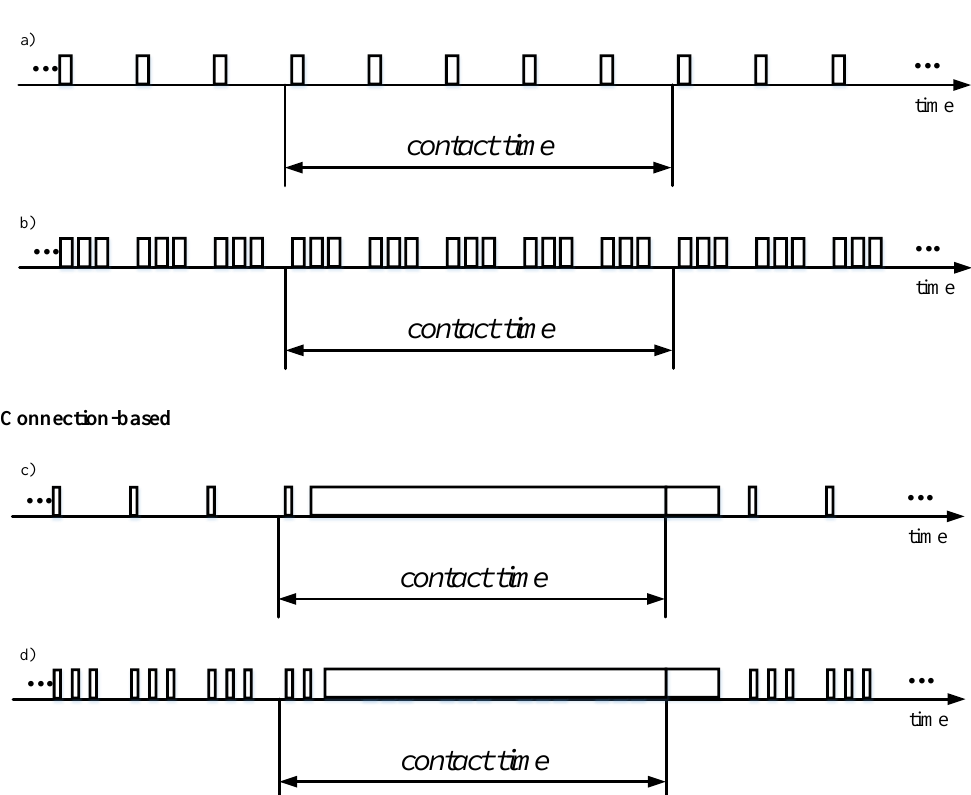
Figure 2. Illustration of the two main OSDC approaches with BLE, for the two different advertisement settings in each one. ( a ) advertisement-based approach with one advertising packet per advertising event; ( b ) advertisement-based approach with three advertising packets per advertising event; ( c ) connection-based approach with one advertising packet per advertising event; ( d ) connection-based approach with three advertising packets per advertising event.